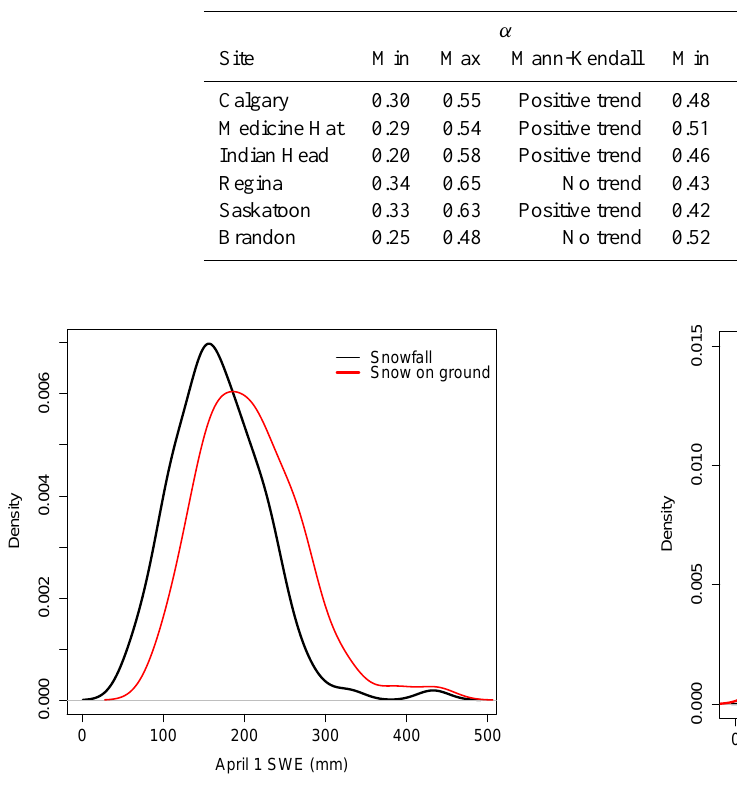
Fig. 6a. Density plot of 1 April cumulative seasonal snowfall at Banff, AB and snow on ground at Bow River snow course (1937– 2009). The horizontal distance between the two sites is approxi- mately 3km, and the difference in elevation is less than 200m.